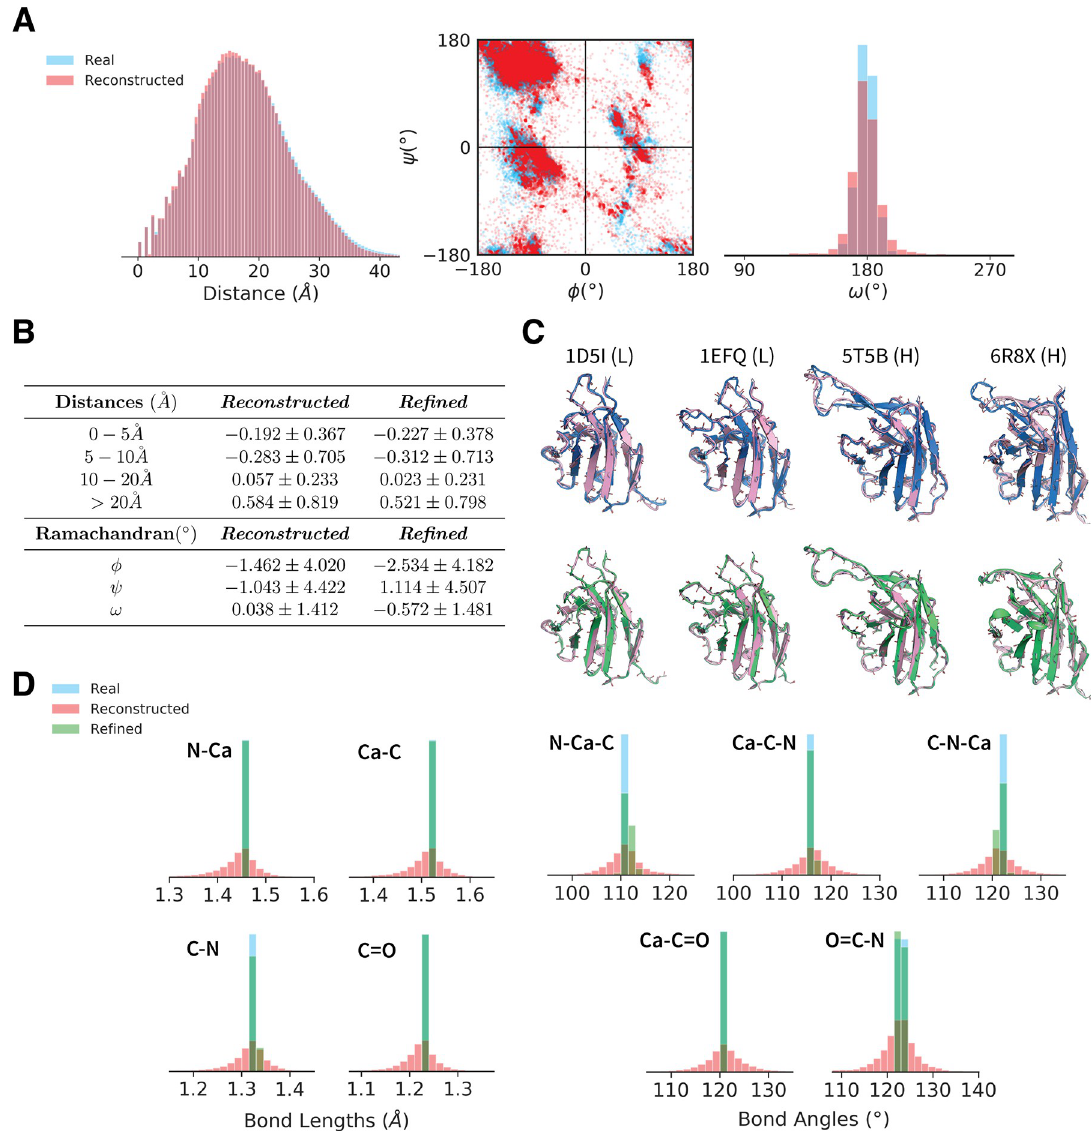
Fig 2. Analysis of Full-Atom Reconstructions. Reconstruction data for 500 randomly chosen, non-redundant structures in the training set. (A) Overlays of the pairwise distance and Ramachandran distributions of the real and reconstructed data. (B) A table of the reconstruction errors in pairwise distance and Ramachandran angle before and after refinement. The distance errors are reported as per- pairwise-distance error averaged over all structures in the dataset, and analogously for the angle errors. (C) Overlays of the real (blue), reconstructed (pink) and refined (green) structures. (D) Overlays of the bond length and bond angle distributions of the real, reconstructed and refined data. Overall, structures are accurately reconstructed, and errors in atom placement are small enough that they can be corrected with minimal changes to the model